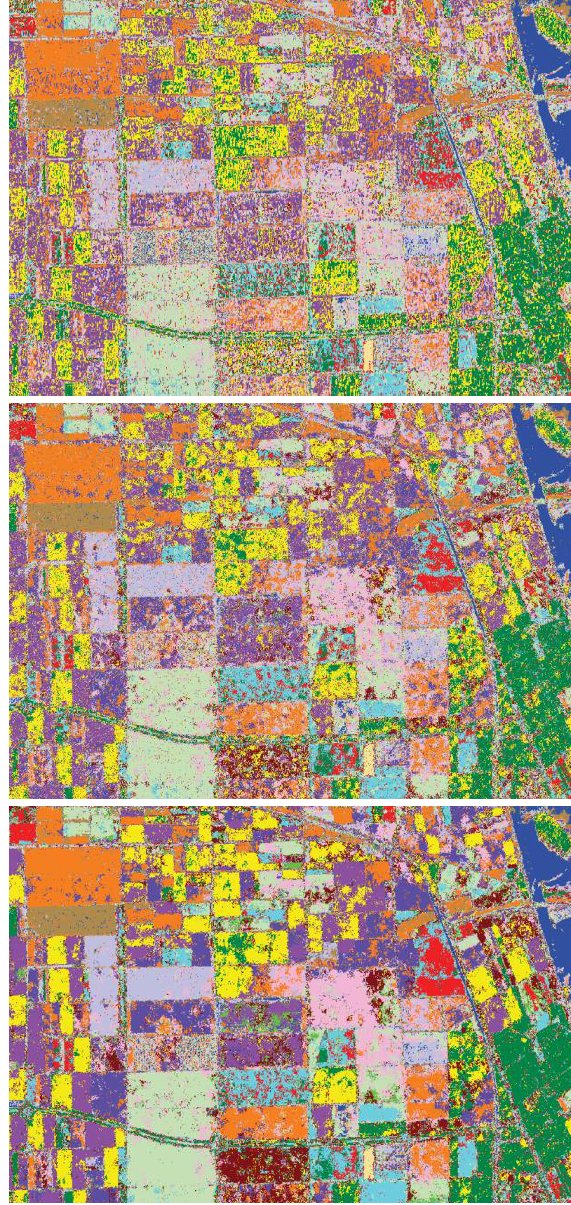
Figure 5. Classification results of the Flevoland area. From top to down, classification results based on the POSSC, PNGF, and the ANLM PolSAR de-speckling methods,